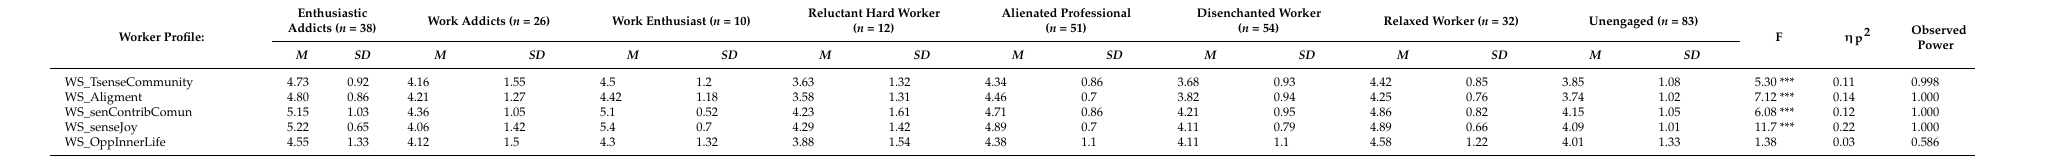
Table 6. Descriptive statistics (M; SD), Univariate tests (F), effect size ( η 2 p ) and observed power (1- β ) of worker